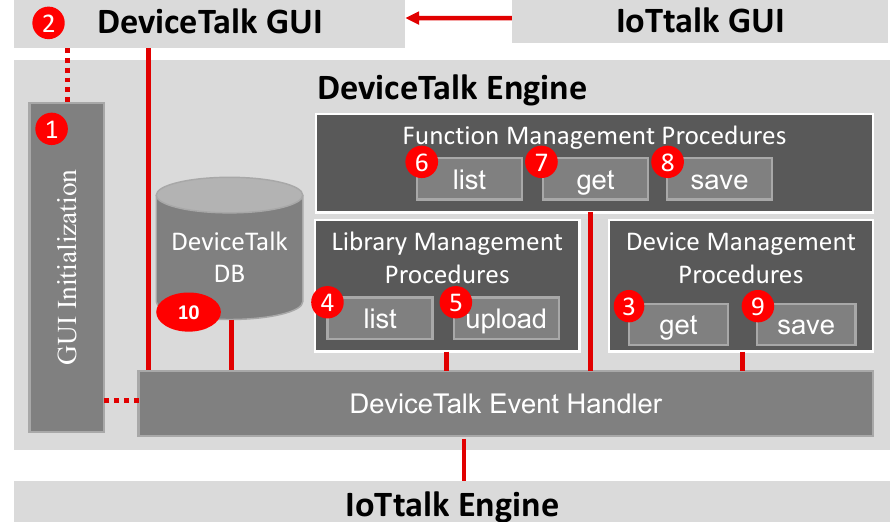
Figure 3. The procedures of the DeviceTalk Engine.